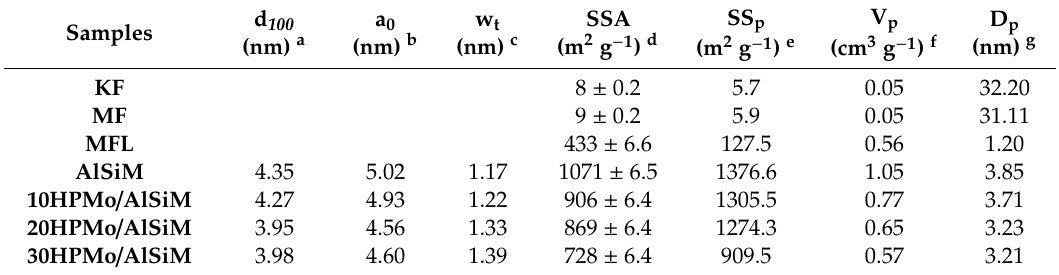
Table 2. Structural and textural properties of AlSiM and (10, 20 and 30) HPMo / AlSiM.